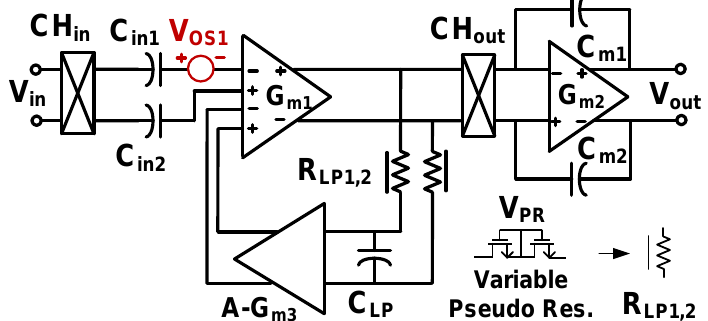
Figure 3. Schematic of the main path of CCIA with the block of proposed A-OCL.